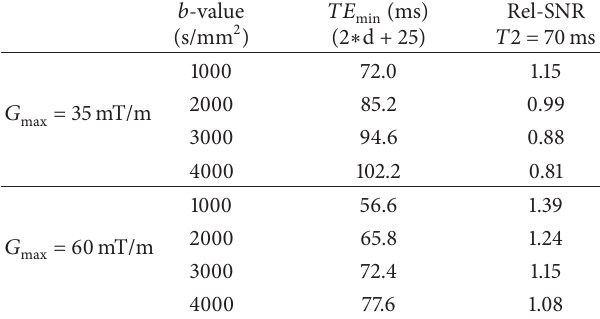
Table6:TheSNRrelativetothatforaTEequalto 𝑇2 (assumedtobe 70 ms) for different 𝑏 -values and two maximum achievable gradient strengths 𝐺 max